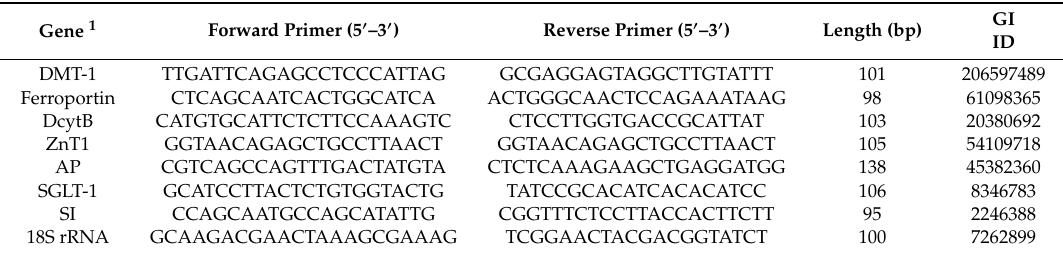
Table 2. Sequences of primers used in this